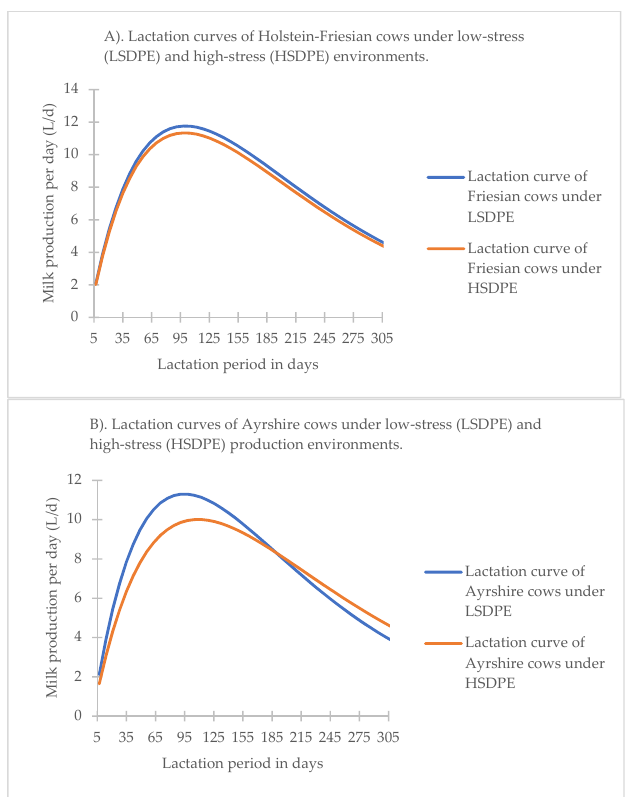
Figure 3. Lactation curves of dairy cows managed under low- and high-stress production environ-